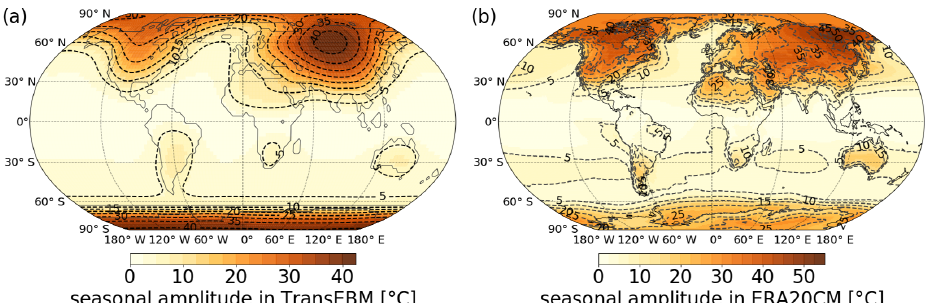
Figure 12. Amplitude of the seasonal cycle in surface temperature during the 20th century in TransEBM v. 1.0 and ERA-20CM based on the extrema in the sinusoids fitted to the seasonal cycles. Simulation as in Fig. 10. TransEBM shows similar patterns to the reanalysis but simulates smaller